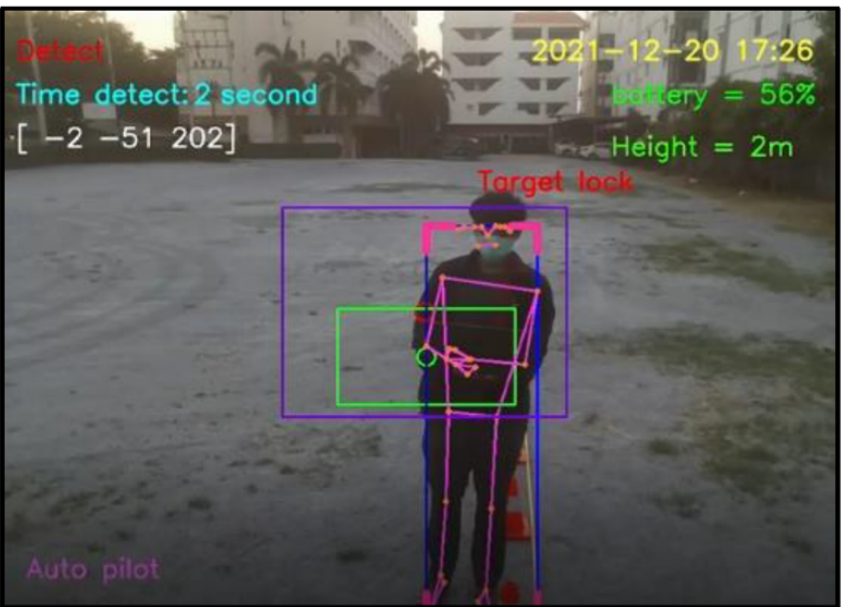
Figure 22. Exploration of light intensity for human motion detection in the afternoon.